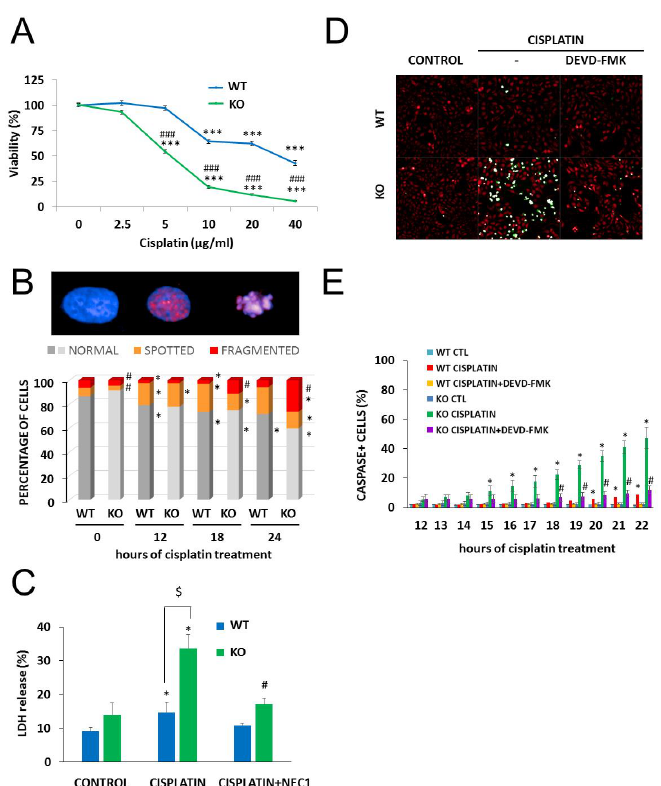
Figure 3. Chemosensitivity of NMNAT-1 KO cell line. Chemosensitivity of wild type (WT) and knockout (KO) cells was compared in a Calcein-AM viability assay 24 h after treatment with different concentrations of cisplatin (0.625 –10 μg/mL). A new batch of cisplatin was used for this and all subsequent experiments. Results are expressed as percentages, compared to the vehicle (medium) treated samples. Data points marked with asterisks are significantly different from the control (Bonferroni test; *** p < 0.001). Data points marked with hashmarks are significantly different from the corresponding treatment of the wild type cells (Bonferroni test; ### p < 0.001). ( A ). Cisplatin-induced DNA damage was assessed by quantifying the P-H2AX signal after immunofluorescent staining. High- content analysis detected three different cell morphologies, “normal”, “spotted” and “fragmented”, representative images are shown ( B ). Chart shows the percentage of the three types of morphologies in untreated and in cisplatin-treated samples at 12, 18, and 24 h after cisplatin treatment. Bars marked with asterisks are significantly di ff erent from the control (0 hours of cisplatin treatment) (Student–Newman–Keuls method; * p < 0.05). Bars marked with hashmarks are significantly di ff erent from the corresponding treatment of the wild type cells (Student–Newman–Keuls method; # p < 0.05) ( B ). Error bars are not shown on panel B because of the 3D presentation. Lactate dehydrogenase (LDH) release was determined from the supernatants at 24 h after cisplatin treatment and expressed as a percentage of the positive control (lysed cells). Cells were treated with cisplatin or with the combination of cisplatin with the necroptosis inhibitor, concentration necrostatin-1 (NEC1). Bars marked with asterisks are significantly di ff erent from the control (not shown) (Dunnett test; * p < 0.05). Bars marked with hashmarks are significantly di ff erent from the cisplatin-treated samples (Dunnett test; # p < 0.05). Bars marked with $ are significantly di ff erent from the corresponding treatment of the wild type cells (Dunnett test; $ p < 0.05) ( C ). Apoptotic cell death was measured with a fluorogenic caspase-3 substrate in a kinetic assay on a Perkin Elmer Opera Phenix High Content Analyzer. Representative images ( D ) show the caspase activity signal (green) with digital phase contrast (red) at 22 h after cisplatin treatment. Images were taken every hour between 12 and 22 h after cisplatin treatment. Some samples were pretreated with the caspase-3 inhibitor z-DEVD-FMK as shown. The numbers of caspase positive cells are shown as a percentage of the actual number of cells. Data points marked with asterisks are significantly di ff erent from the control (12 h of cisplatin treatment) (Student–Newman–Keuls method; * p < 0.05). Data points marked with hashmarks are significantly di ff erent from the cisplatin treated samples Student–Newman–Keuls method; # p < 0.05). ( E ). Means ± SEM are shown ( n =